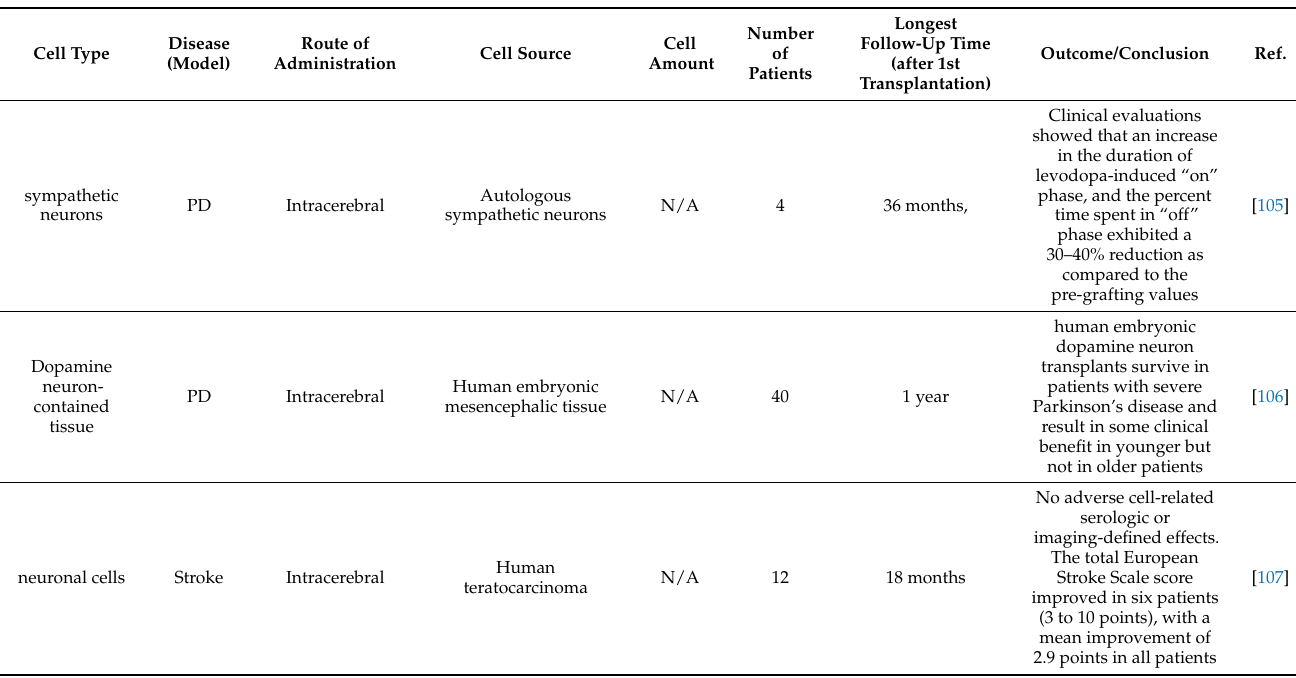
Table 4. Examples of neuron transplantation for neurological disorders in clinical trials (data from PubMed).